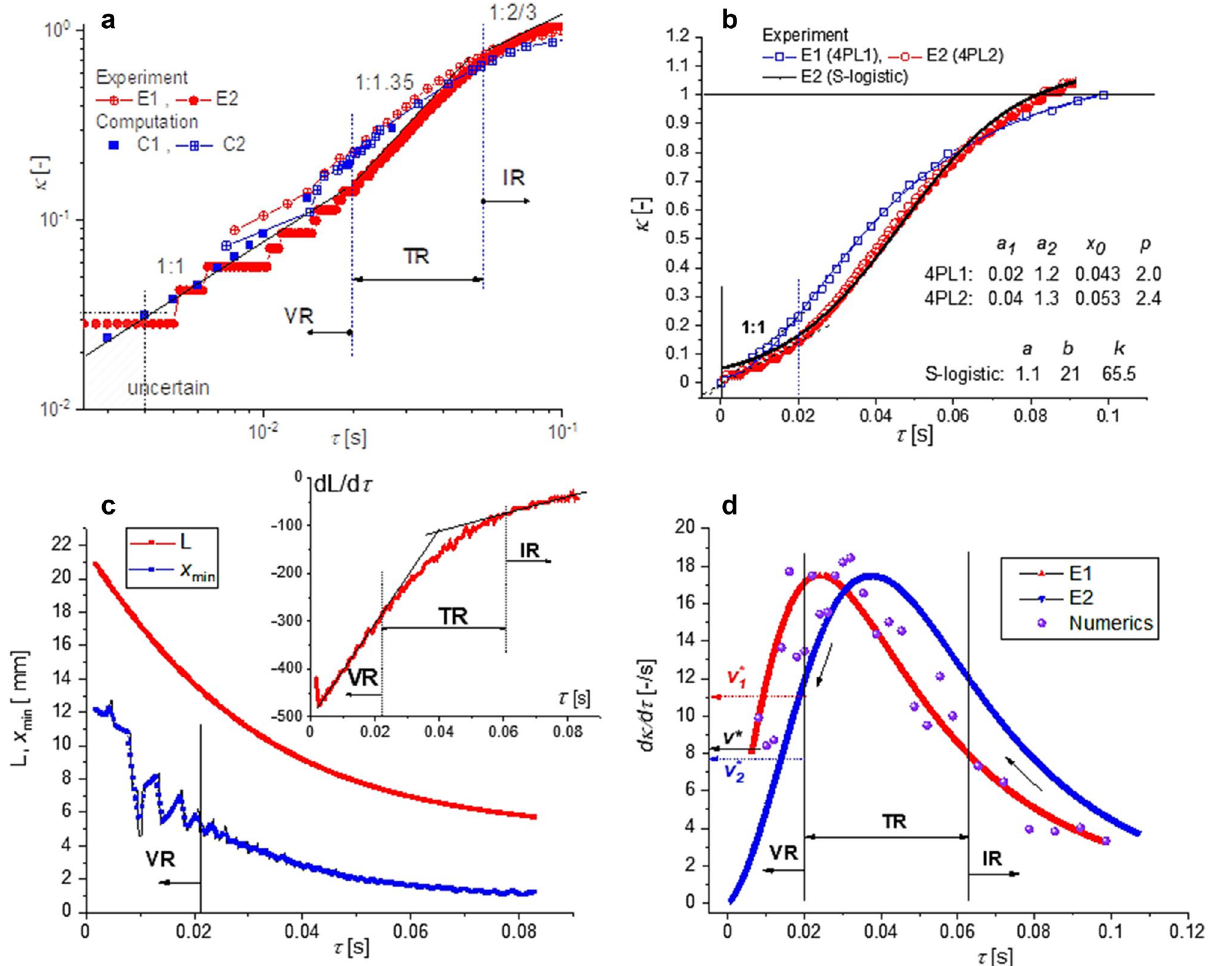
d min / d 0 as function of the relative time τ (experiment and =